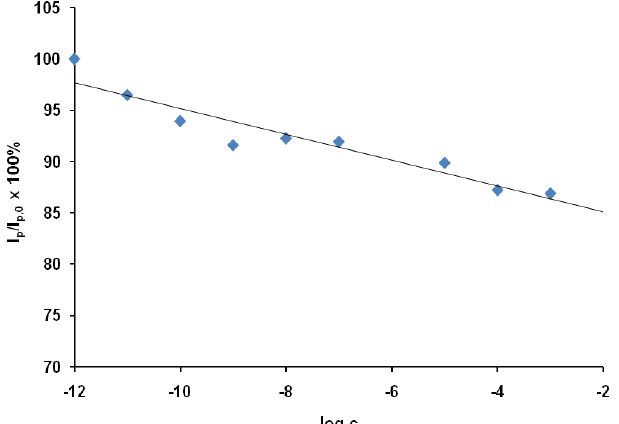
Figure 4. The response of Hb/SWCNT/GCE electrodes towards acrylamide in the presence of water extract from the potato crisp. The ratio of OSWV peak current in the presence of a given concentration of acrylamide ( I ) to that in absence of analytes ( I ) was plotted p p,0 versus the concentration of acrylamide in water extract from the potato crisp. The currents were measured at the peak potential in OSWV curves in the solution with no analyte ( E = p,0 38 mV); ( n = 3; 3.1 < S.D. <